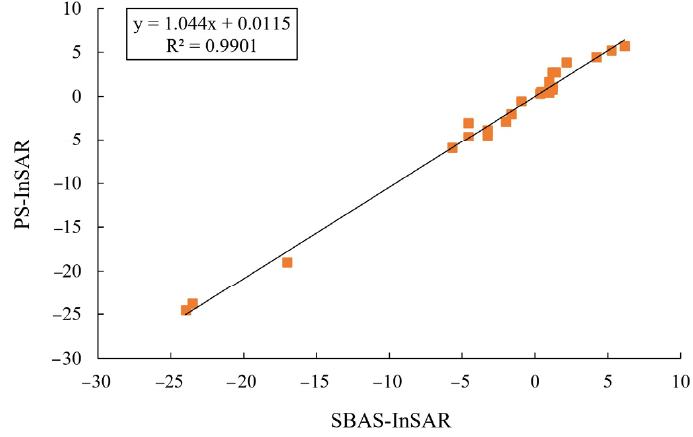
Figure 6. Linear regression plots of PS-InSAR and SBAS-InSAR sedimentation rates at sample sites (Unit: mm/a).